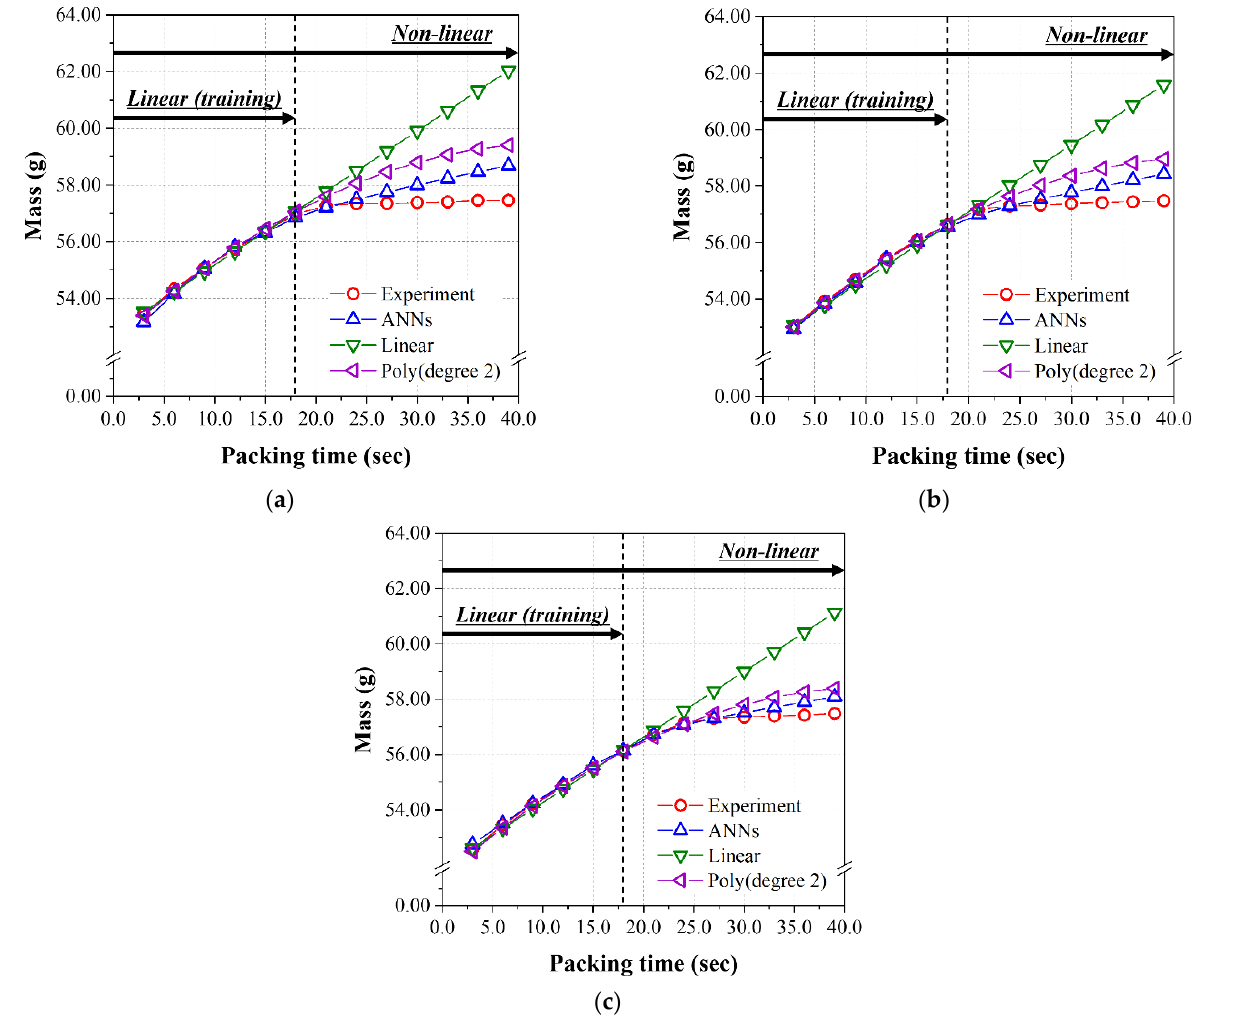
Figure 8. Predicted mass of nonlinear relation group from Table A2 using the models learned by the linear relation group (packing time was 3.0–18.0 s). Melt temperatures; ( a ) 200 °C, ( b ) 220 °C, and ( c ) 240 °C.